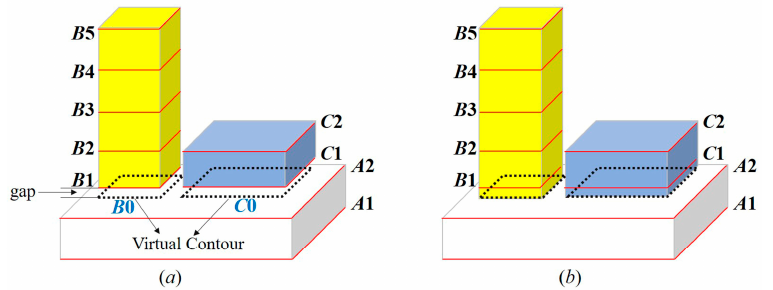
Figure 3. Virtual contours: ( a ) the existing gap and virtual contour; ( b ) a complete model by filling the gap.